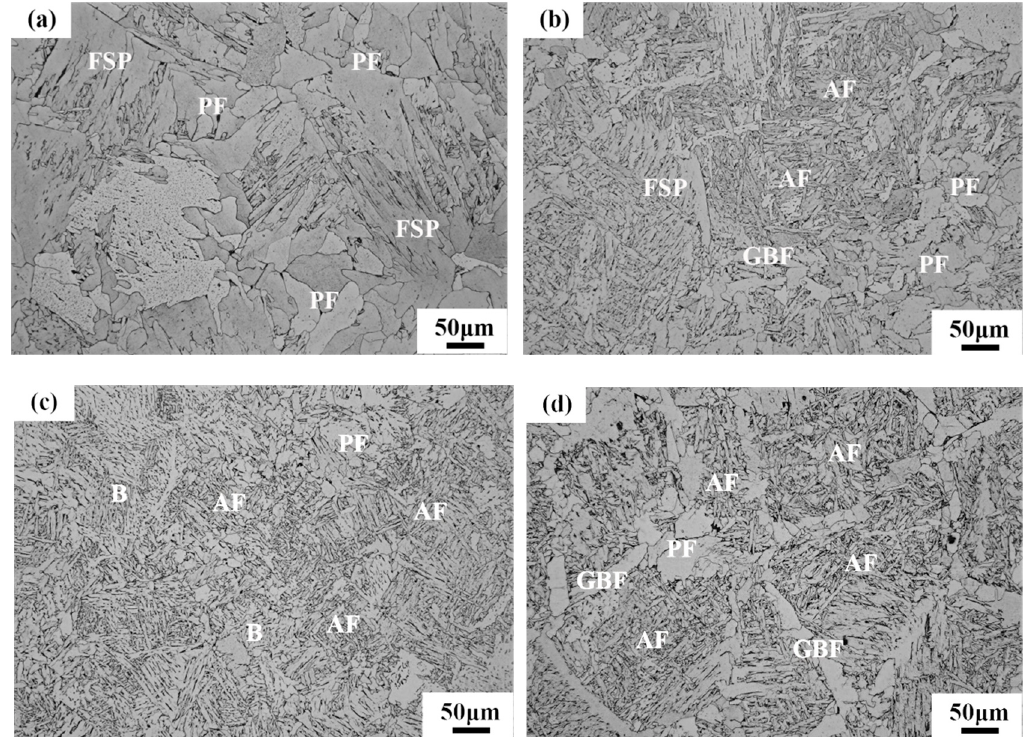
Figure 3. Evolution of microstructure in EH420-Mg: ( a ) the LF furnace station; ( b ) Ti-Mg treatment in the LF furnace; ( c ) vacuum treatment in the RH furnace; ( d ) after the thermal welding simulation. AF, acicular ferrite; PF, polygonal ferrite; GBF, grain boundary ferrite; FSP, ferrite side plate; B, bainite.